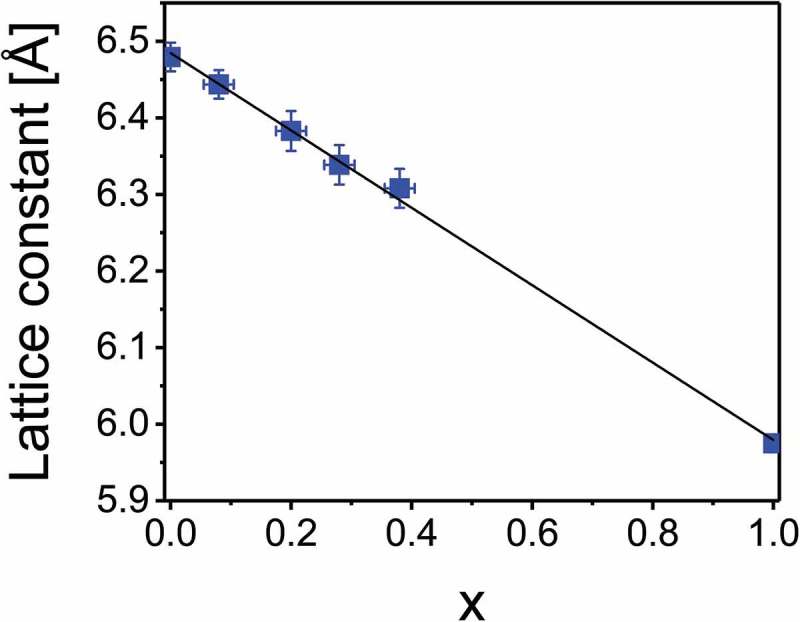
Lattice constant of CdTe1-xSex thin films on glass substrate. The value for zinc blende CdSe (x = 1) was taken from literature [23].